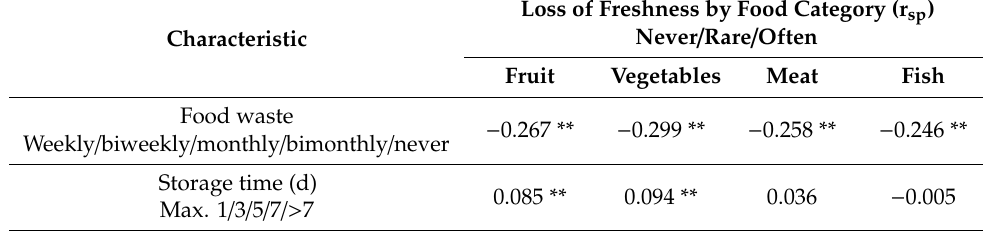
Table 4. Correlations between the loss of food freshness and the rate of food waste, respectively and the storage time for food categories (** = significance r sp at 0.01).